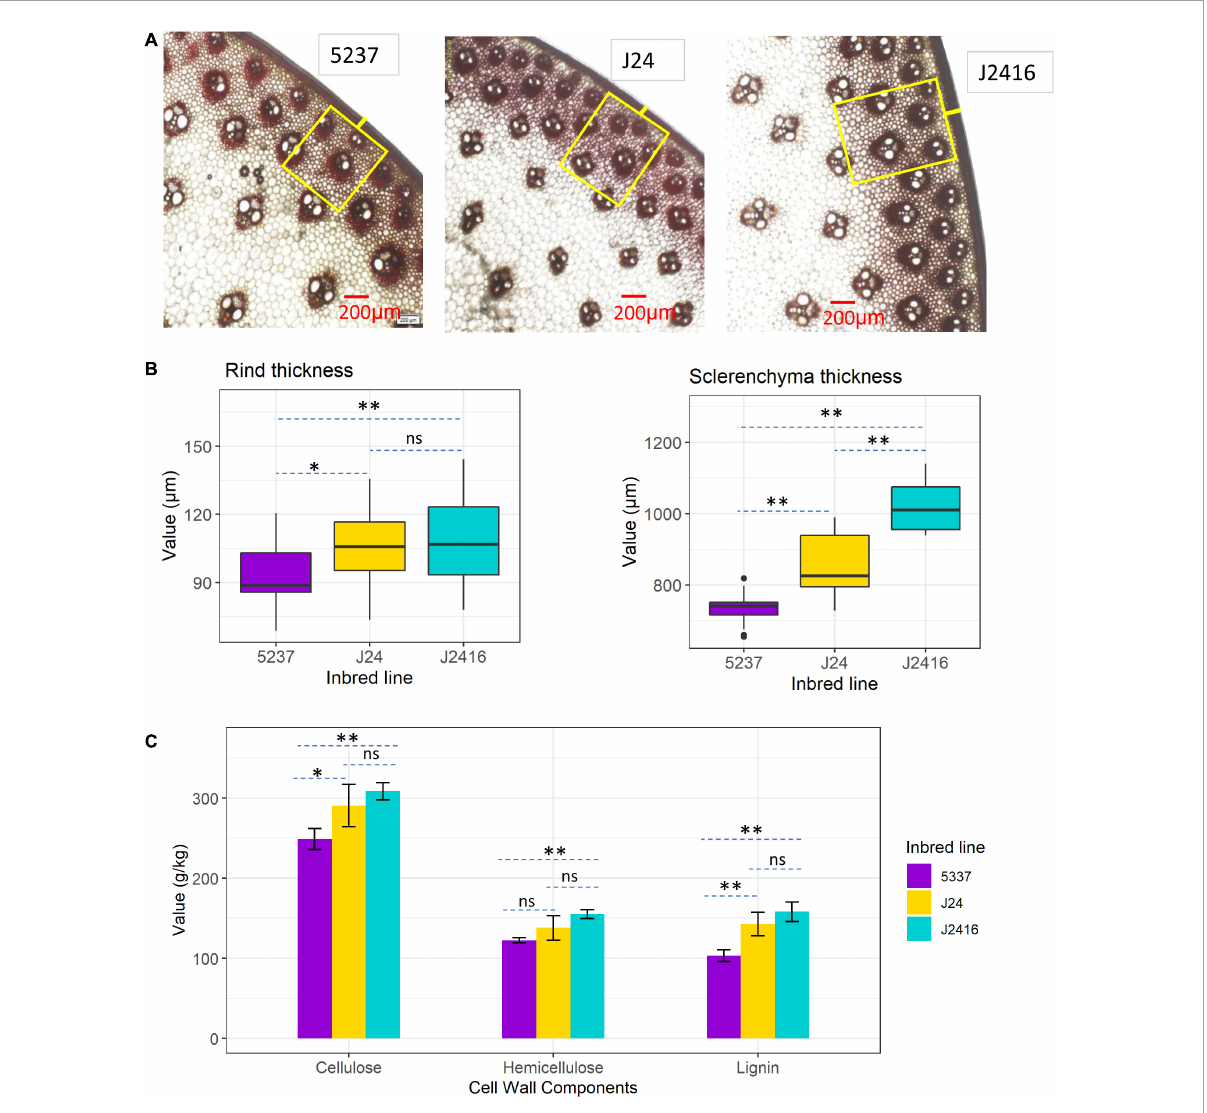
FIGURE3 Stalk anatomical characteristics and cell wall components in J2416 and its two parents. (A) Anatomical characteristics observed in stalk cross sections (200 µ m field) under a microscope. Yellow box represents sclerenchyma tissue; short yellow line in the middle of the box represents rind cells. (B) Rind thickness and sclerenchyma thickness in stalks of the three materials. (C) Contents of cell wall components in stalks of J2416 and its two parents. ∗ , ∗∗ Means the significant difference at 0.05 and 0.01 level, respectively. ns means no significant